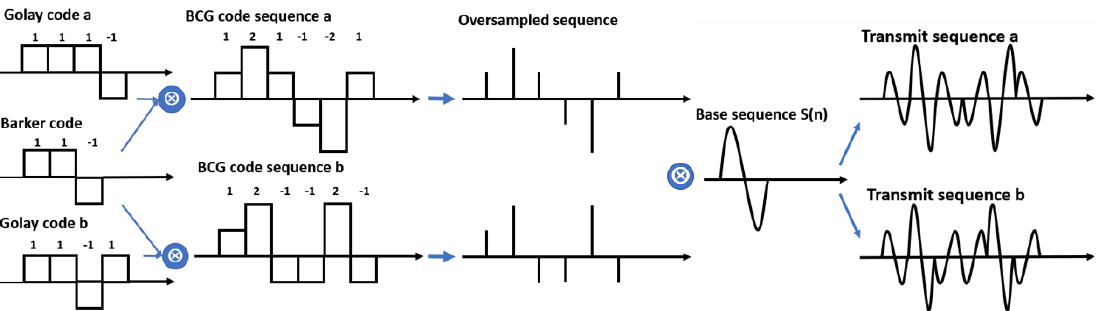
Figure 3. The BCG code pair modulated by sine